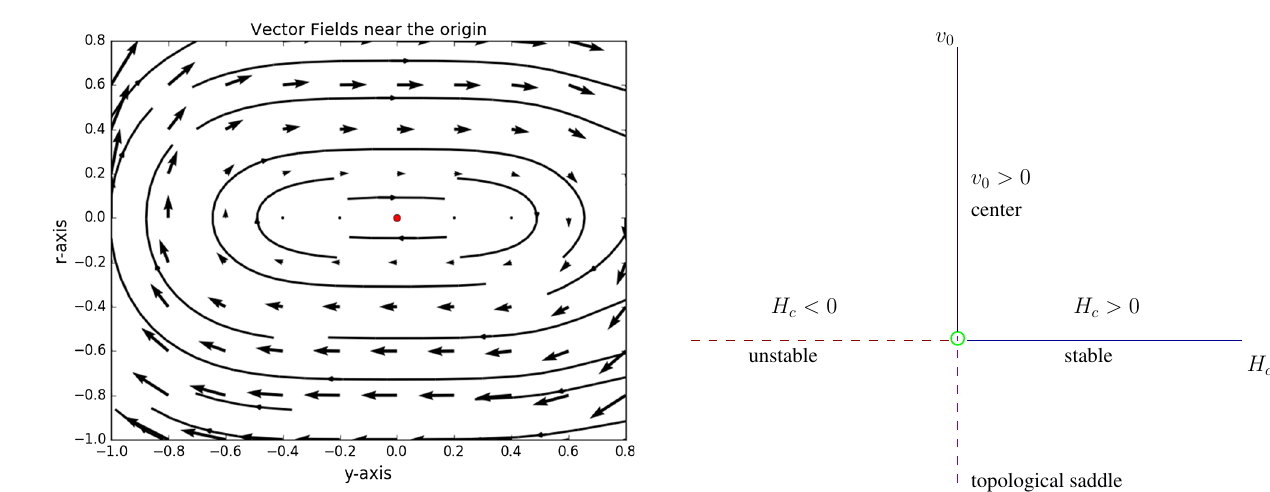
Fig. 4 For n even, origin is a center (for Eqs. 38 and 39)